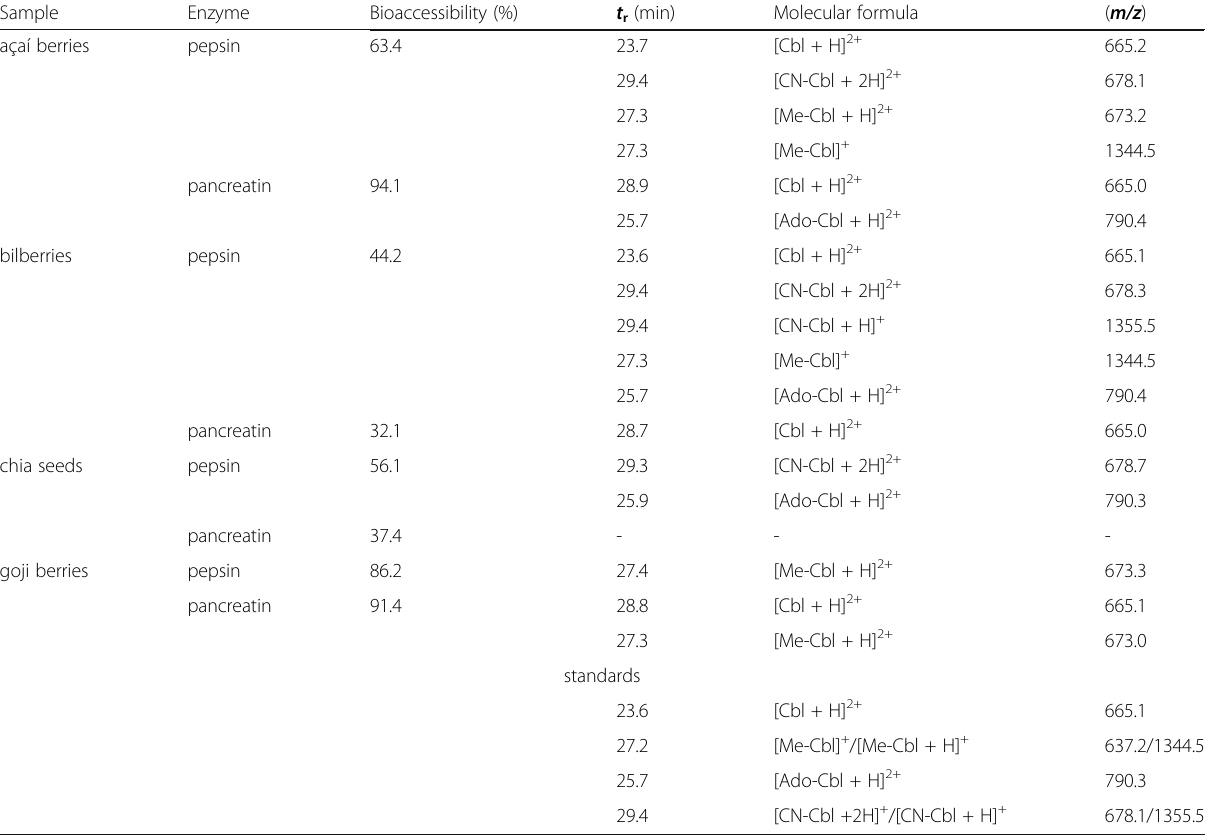
Table 2 Cobalt species observed in enzymatic extracts analyzed by μ -HPLC-ESI-MS Sample Enzyme